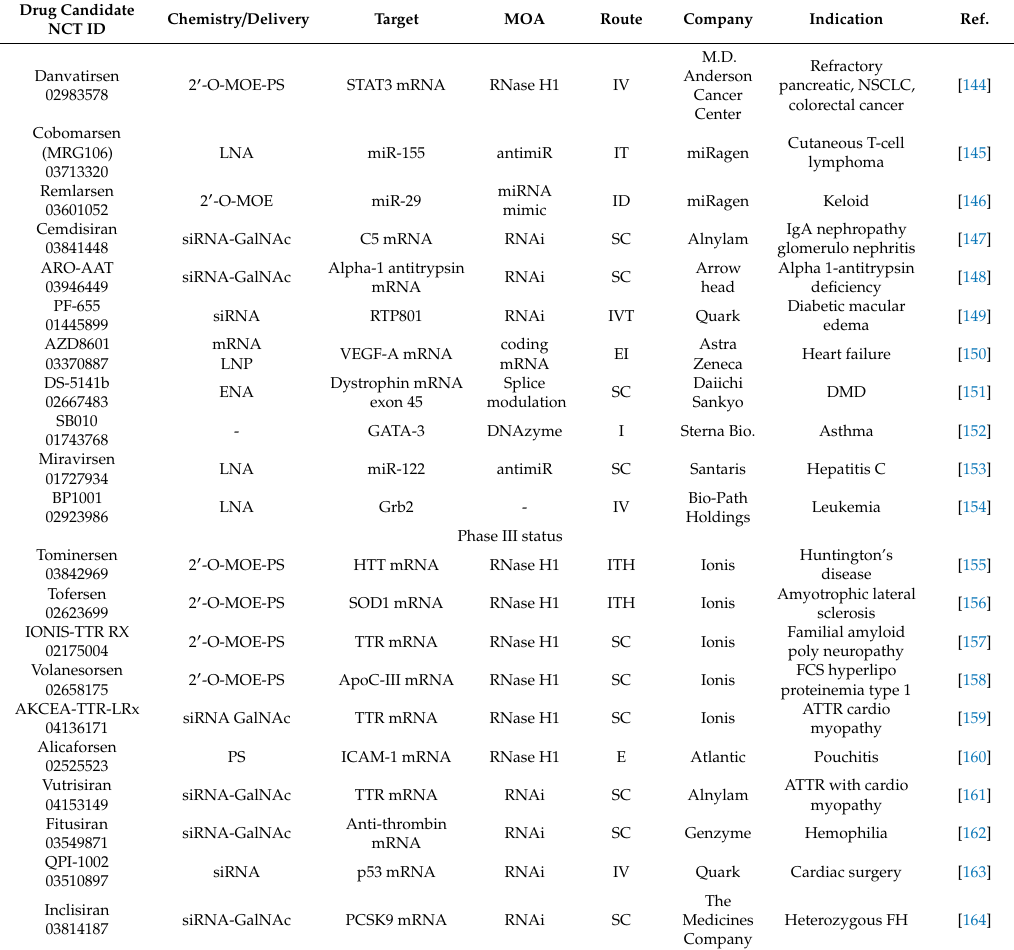
Table 4. Potential drug candidates in clinical